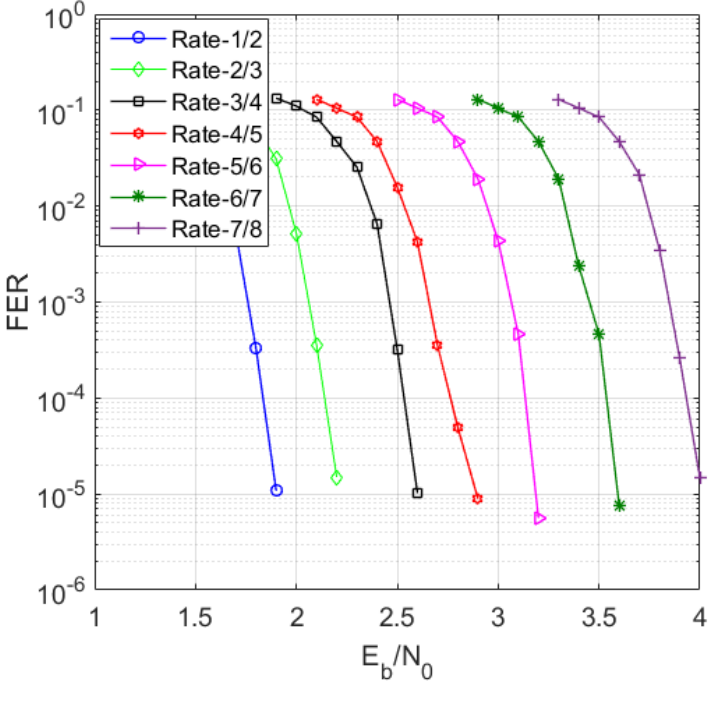
Figure 17. FER simulation result.